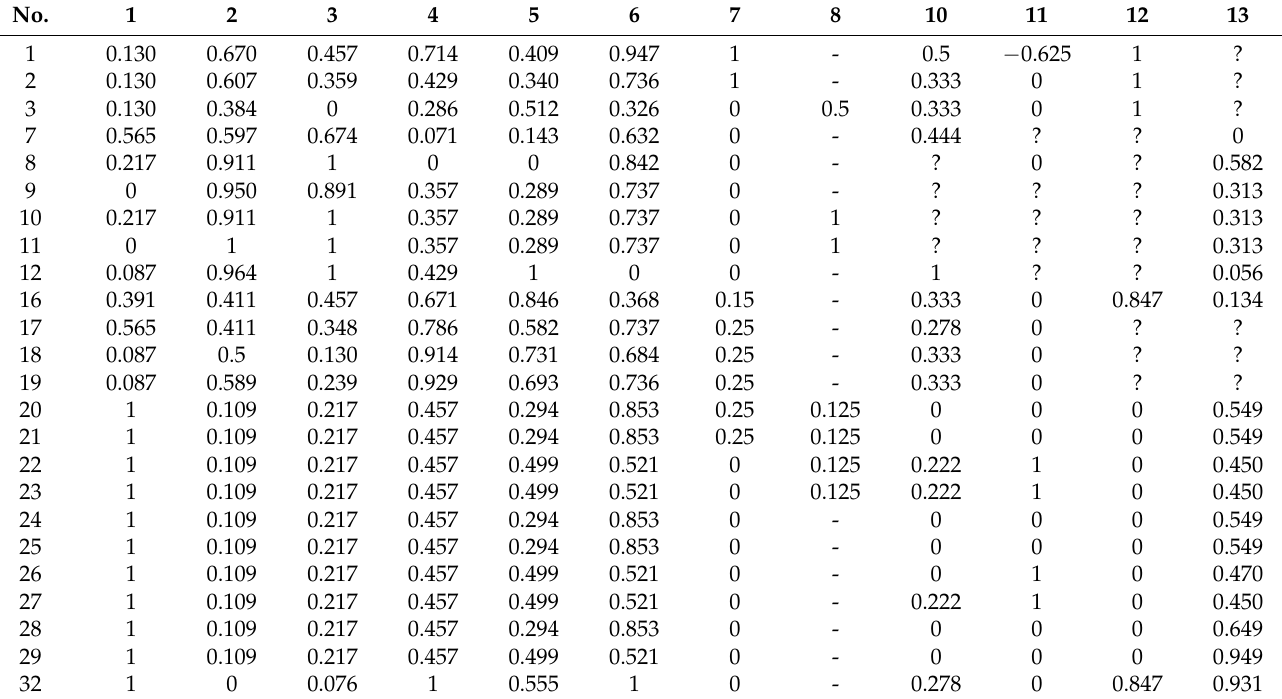
Table A3. Relative dimensionless attribute levels for considered ASHP